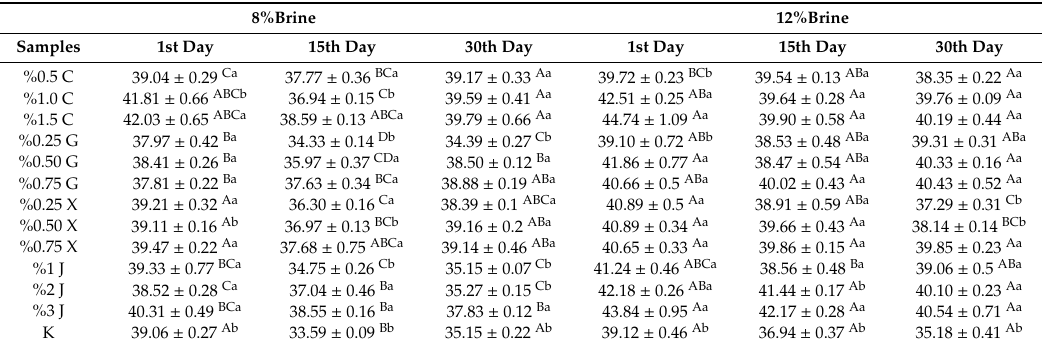
Table 1. Dry Matter (g / 100) of cheese samples during storage. 8%Brine 12%Brine